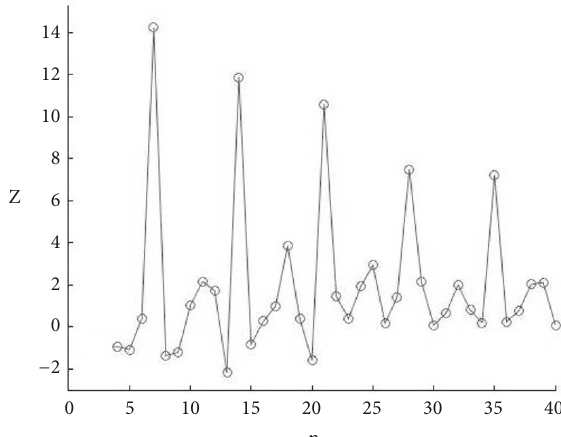
Figure2:Graphof Z ( n )foranartificialsequencerandomlychanged to 50%.